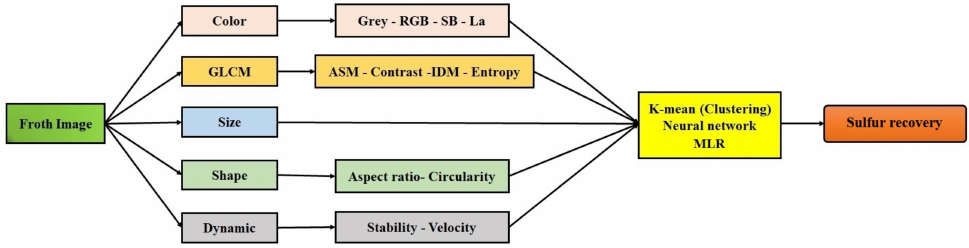
Figure 9. The structure of the inputs and output of the proposed models.